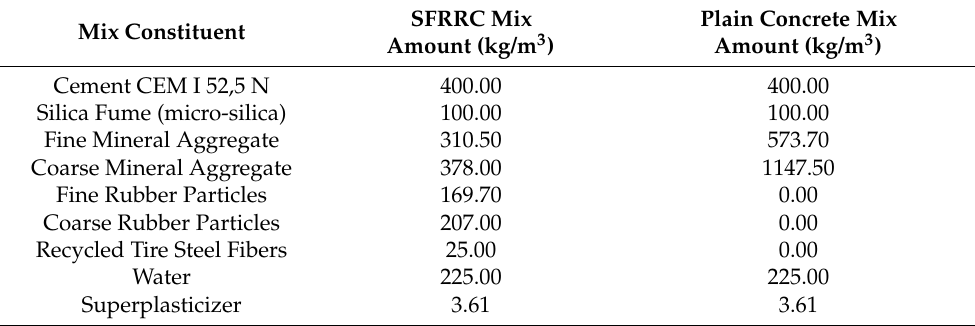
Table 1. Steel Fiber Reinforced Rubberized Concrete with High Rubber Content and Plain Concrete– Mix Design